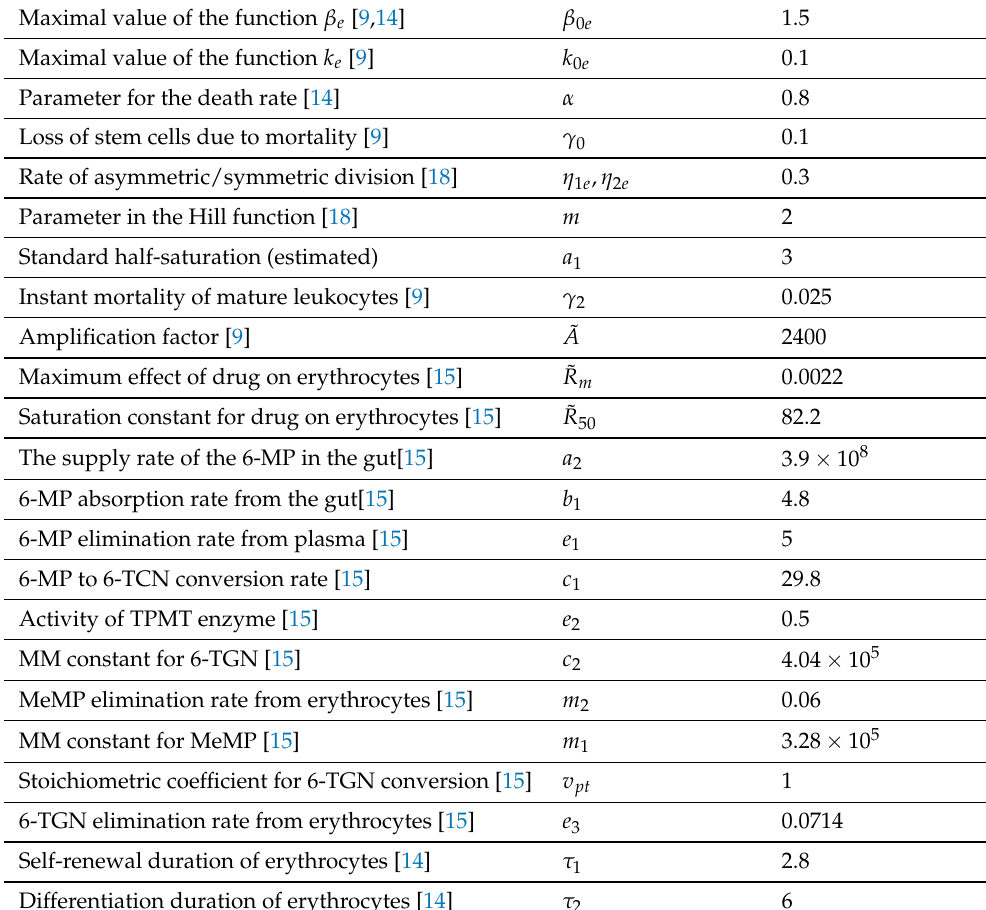
Table 1. Parameter values for the erythropoiesis